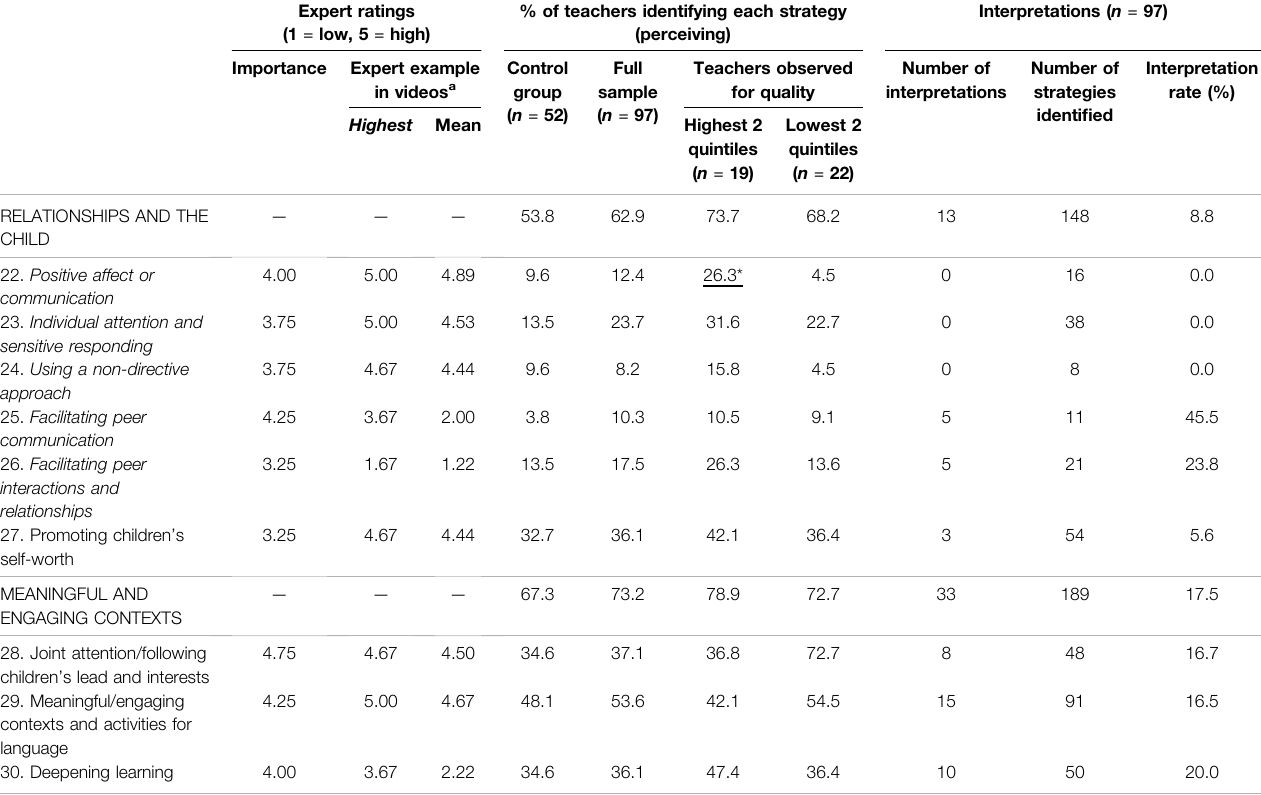
TABLE 1 | ( Continued ) The OLP Framework: expert ratings, strategy identi fi cation rates and strategy interpretation rates. Expert ratings % of teachers identifying each strategy (1 = low, 5 = high)